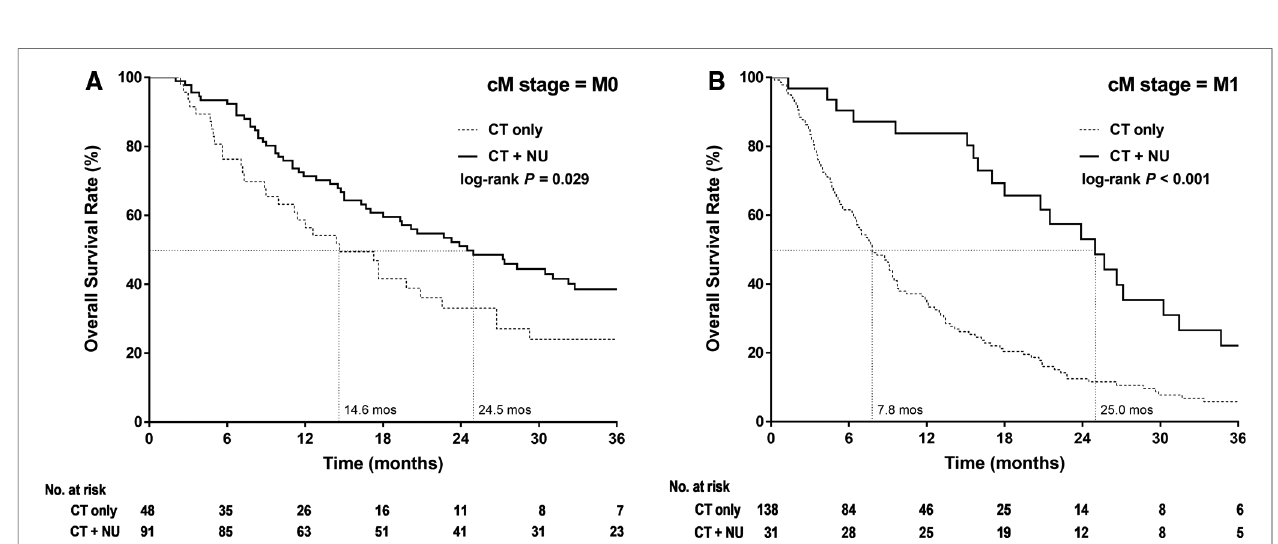
FIGURE 2 | Kaplan – Meier 3-year overall survival curves for patients with stage IV upper urinary tract urothelial cancer strati fi ed by treatment type in ( A ) nonmetastatic and ( B )